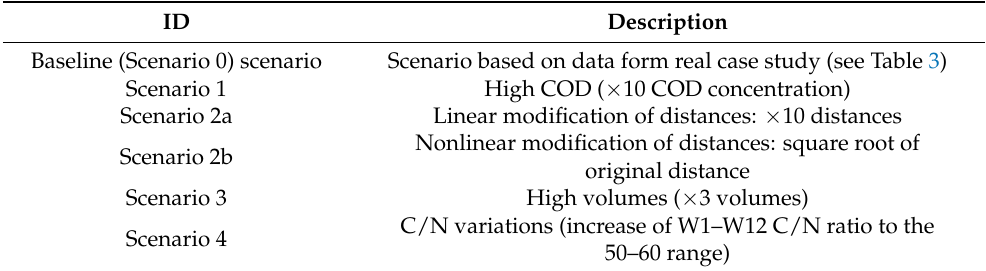
Table 4. Synthetic scenarios created from original Scenario 0 in Table 3. Description of data alter- ation